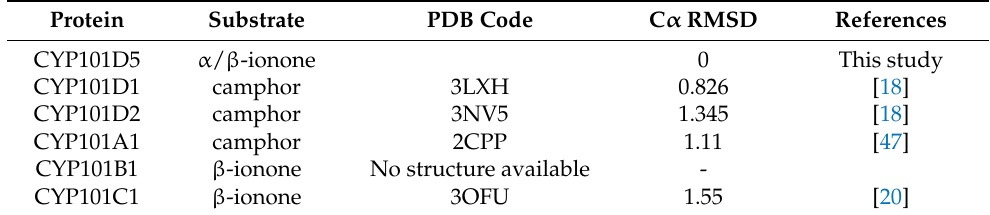
Table 3. Substrate preference of CYP101 family proteins and the RMSD values compared to